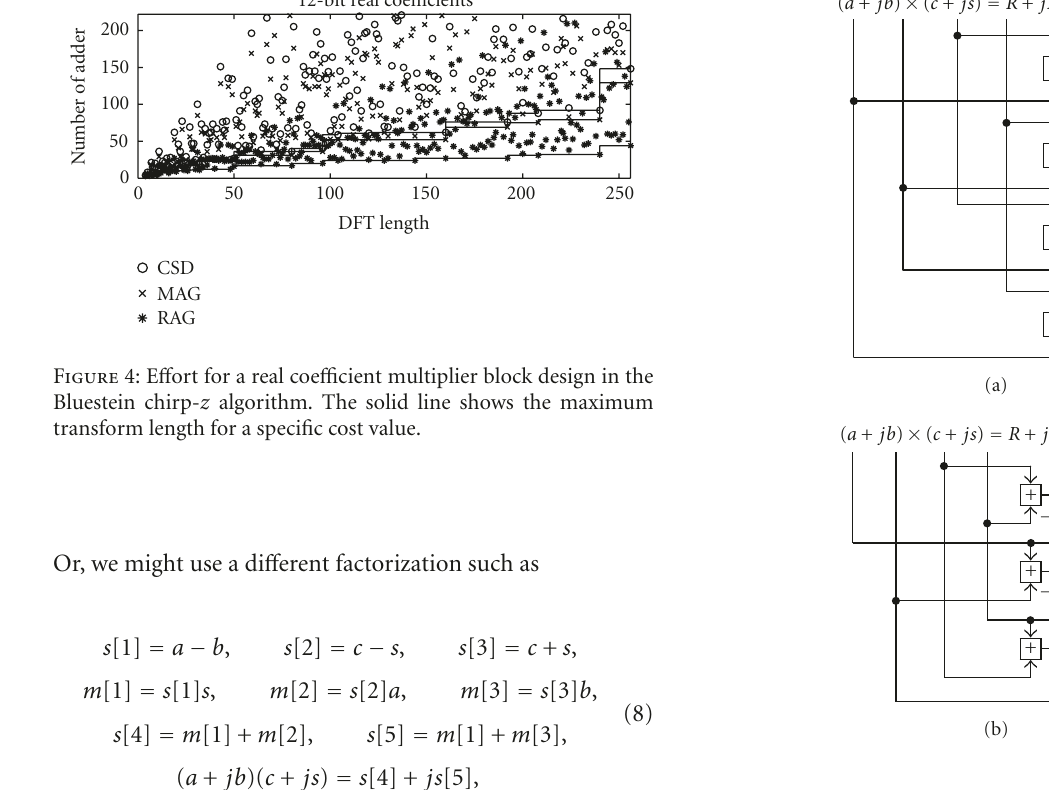
Figure 5: The two complex multiplier versions (a) 4 × 2+, (b) 3 × 5+.